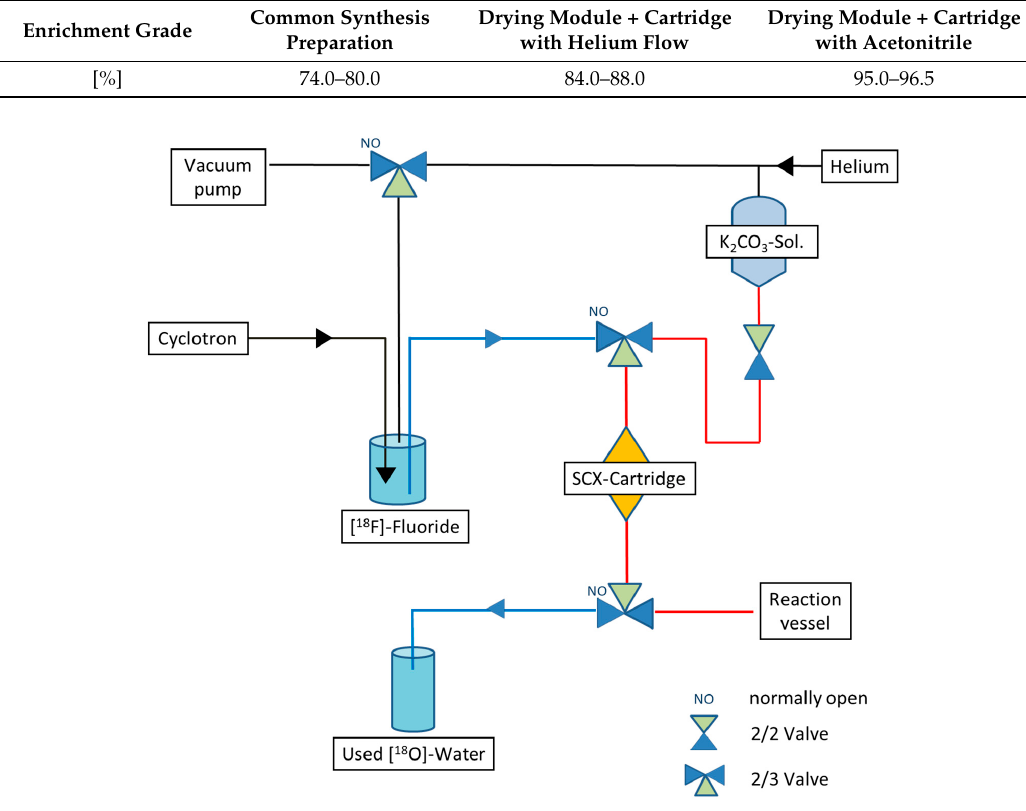
Table 1. Influence of the synthesis preparation on the enrichment grade.